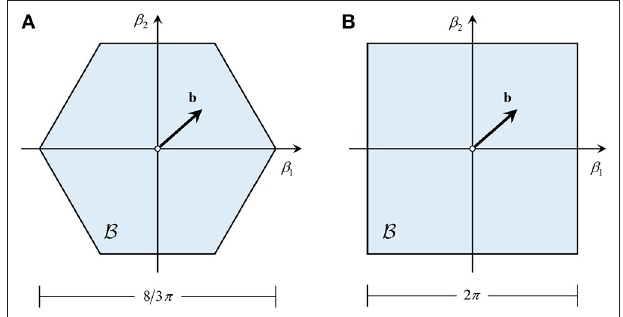
FIGURE 3 | Non-dimensional first Brillouin domain B associated to: (A) hexachiral periodic cell, (B) tetrachiral and anti-tetrachiral periodic